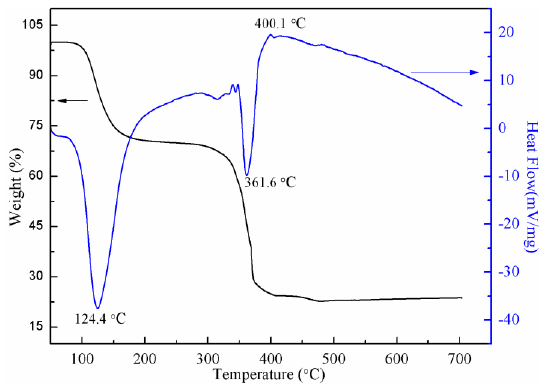
Figure 3. TG (thermogravimetry) and DTA (differential thermal analysis) curves of Figure3. TG(thermogravimetry)andDTA(differentialthermalanalysis)curvesofNi(CH 3 COO) 2 · 4H 2 Ni(CH 3 COO) 2 ∙4H 2 O@GNSs.